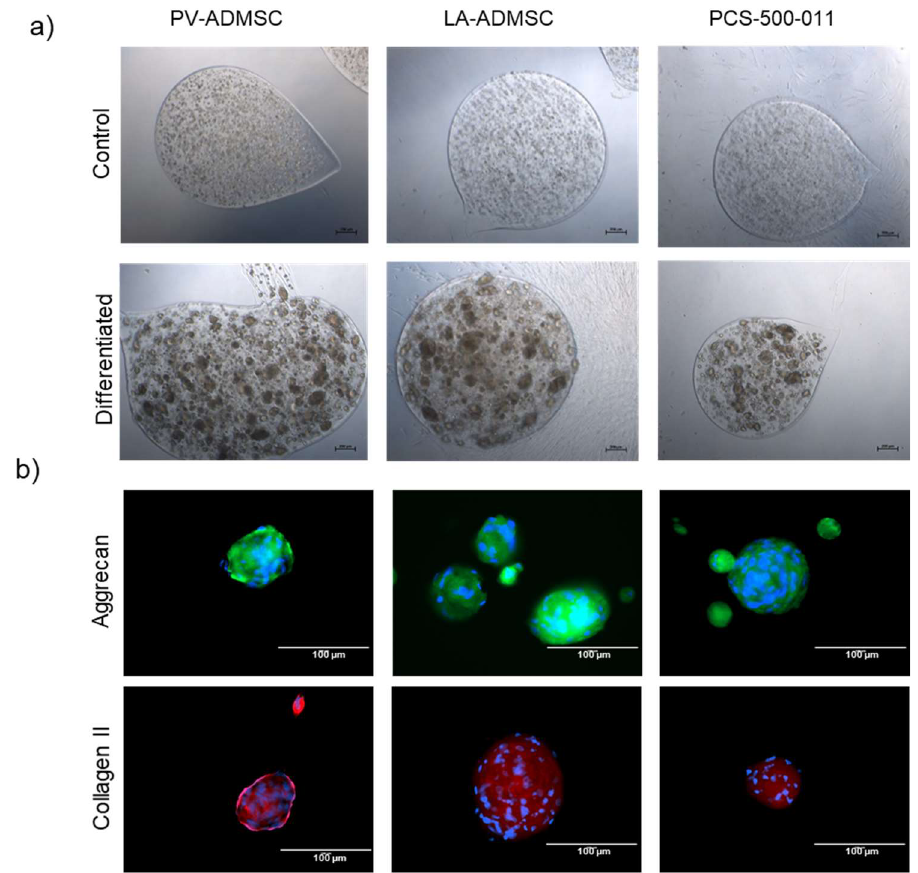
Figure 7. Chondrogenic differentiation in alginate encapsulated human LA-ADMSCs. ( a ) Bright-field microscopic pictures of cells encapsulated in alginate. The upper panel shows cells grown in MSCBM and the lower panel in the chondrocyte differentiation medium. ( b ) Immuno-stained differentiated cell aggregates were stained for aggrecan (upper panel) and type II collagen (lower panel) and assessed by fluorescent microscopy.